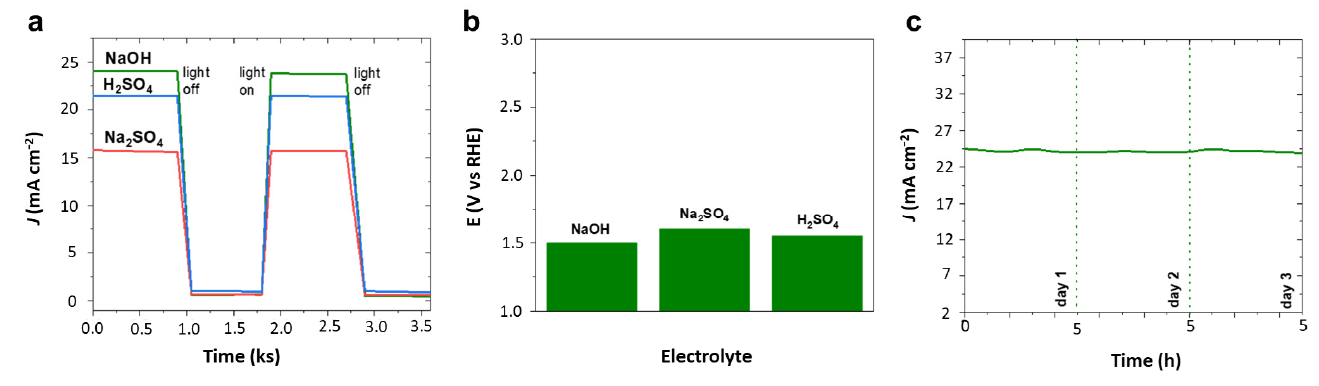
Figure 7. ( a ) Chopped chronoamperometry at 1.8 V (vs. RHE). ( b ) Potential at 10 mA cm − 2 current density. ( c ) Chronoamperometry in 0.1 M NaOH at 1.8 V (vs. RHE) for 4Ir1Ni@ AC catalyst.